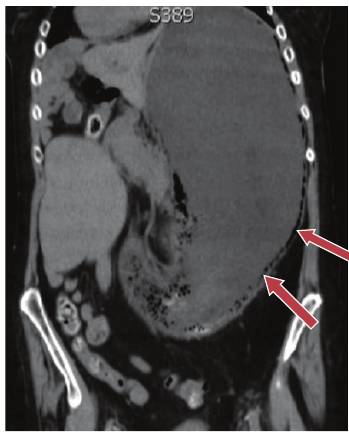
Figure 4: Gastric emphysema better delineated utilizing a bone/lung window on CT scan, sagittal reformat